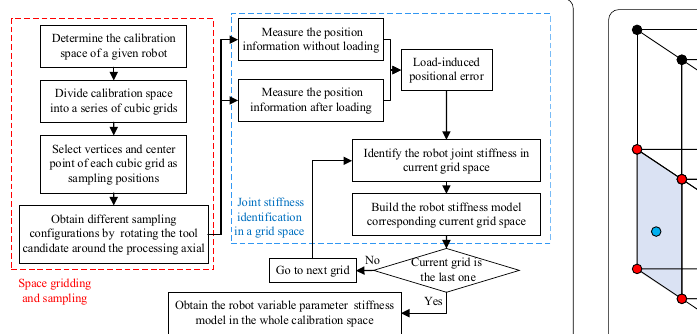
Figure 3 Special scenarios of the target